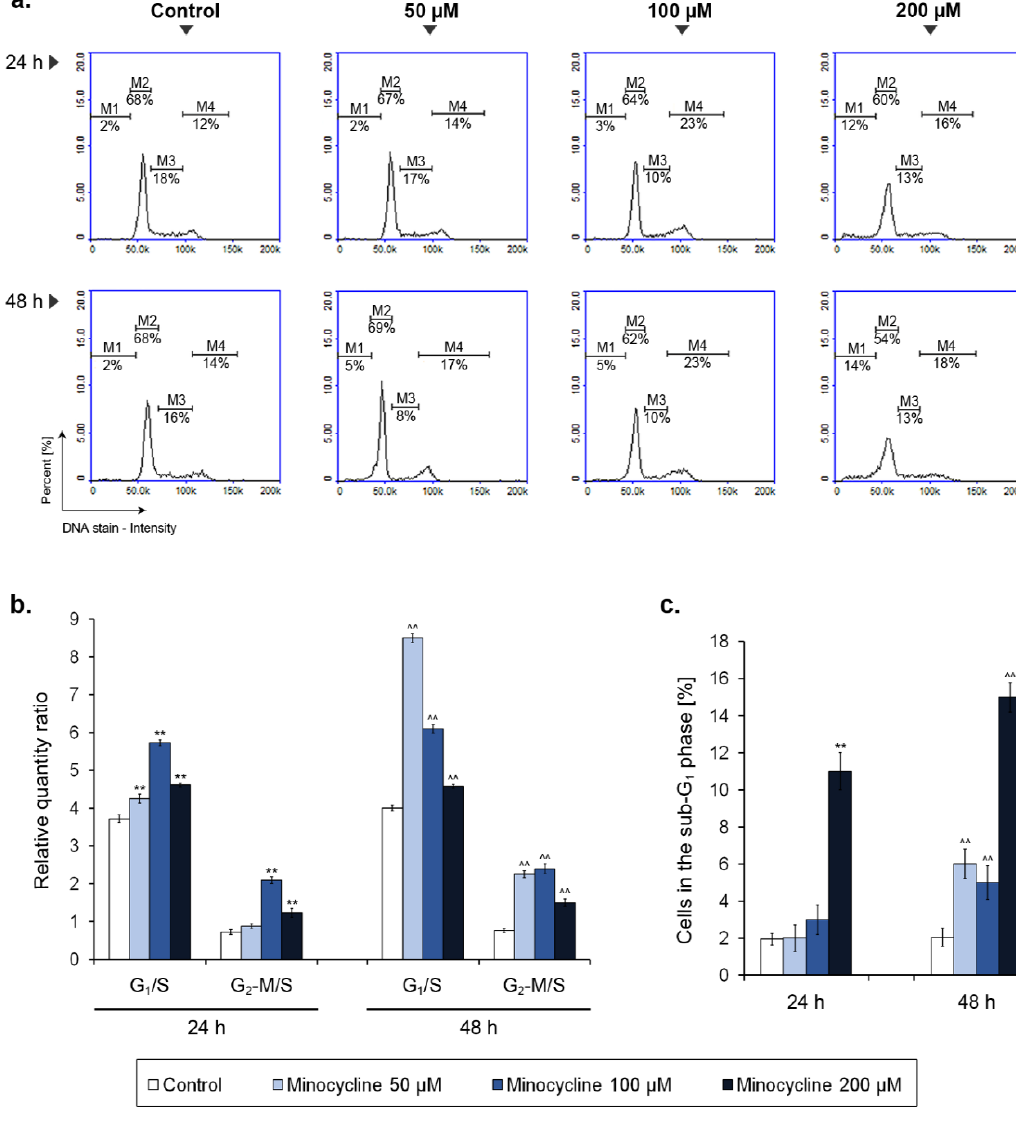
Figure 5. Minocycline-induced changes of cell cycle in human melanoma cells treated for 24 h and 48 h. Representative histograms for the tested groups show distribution of cells in the individual phases of cell cycle ( a ). The results of the cell cycle analysis are presented as a relative quantity ratio of G 1 / S and G 2 -M / S ( b ). The number of cells in the sub-G 1 phase is shown as the percentage of the tested population ( c ). ** p < 0.005 vs. control 24 h; ˆˆ p < 0.005 vs. control 48 h.